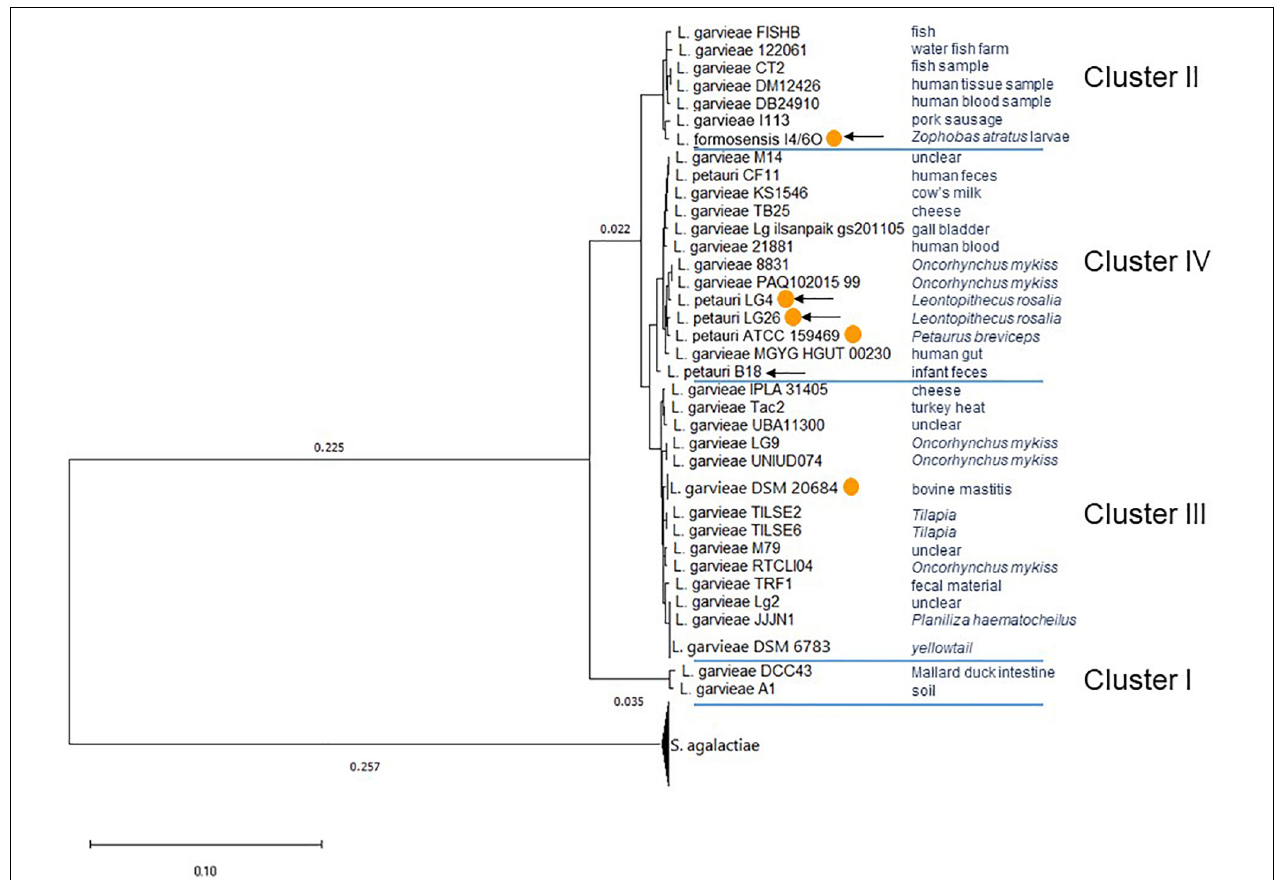
FIGURE 3 | Phylogenetic tree of L. garvieae/petauri/formosensis by core genomes. The phylogenetic tree was built using EDGAR and the neighbor-joining algorithm as implemented in the PHYLIP package with rerooting. The tree is based on the core genome of 50 genomes, comprising 478 core genes each, 23,900 in total. The phylogenetic tree was built from 178,713 AA-residues per genome, 8,935,650 in total. Multiple genome copies of one strain were compressed. Origin of strains was retrieved from NCBI’s genome server. With orange circles: strains that have confirmed pigment formation. With arrows: strains whose genomes were generated in this